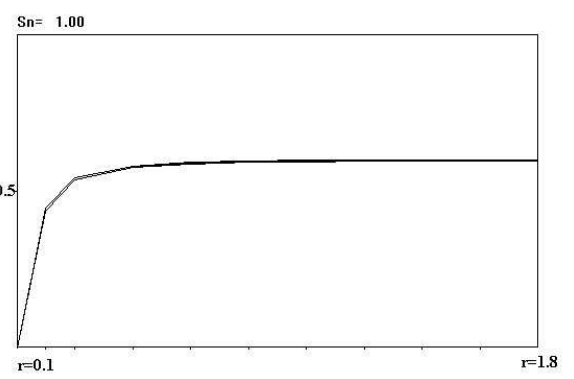
Figure 2: Distribution of oil saturation